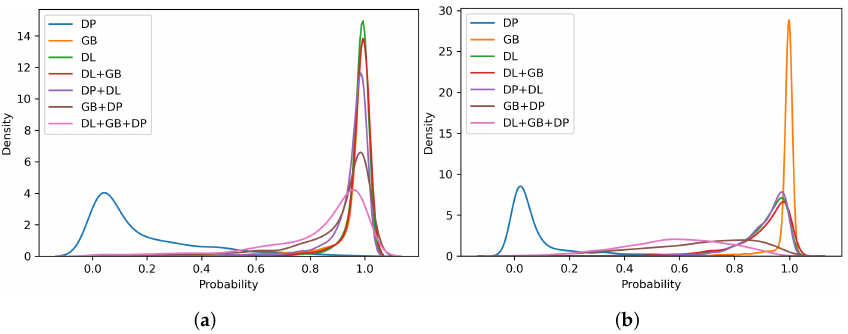
Figure 13. Probability distributions of ( a ) real and ( b ) fake fingerprint scores of the Dermalog Screen- Spoof dataset obtained by the PAD Spoofbuster.